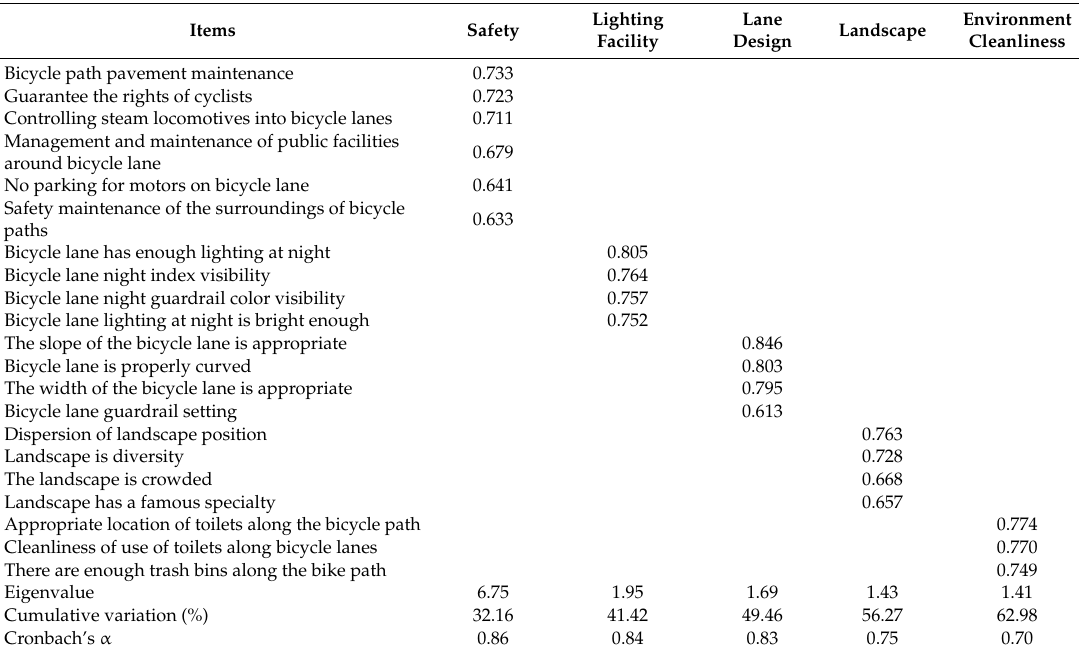
Table 2. Factor analysis of environmental quality for